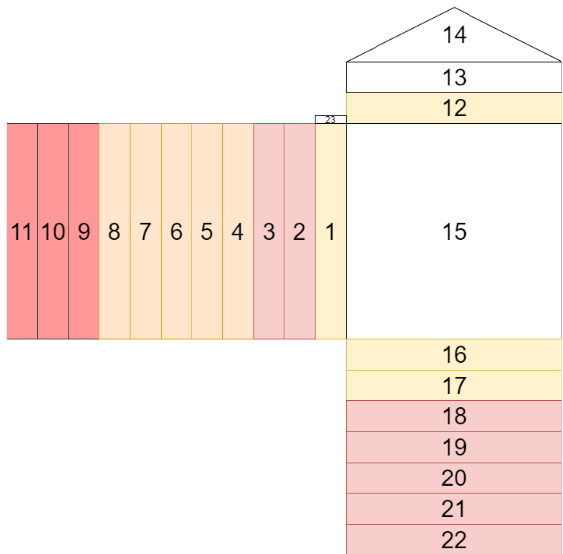
Figure 8. Concept figure of client requirement HoQ or additional requirement